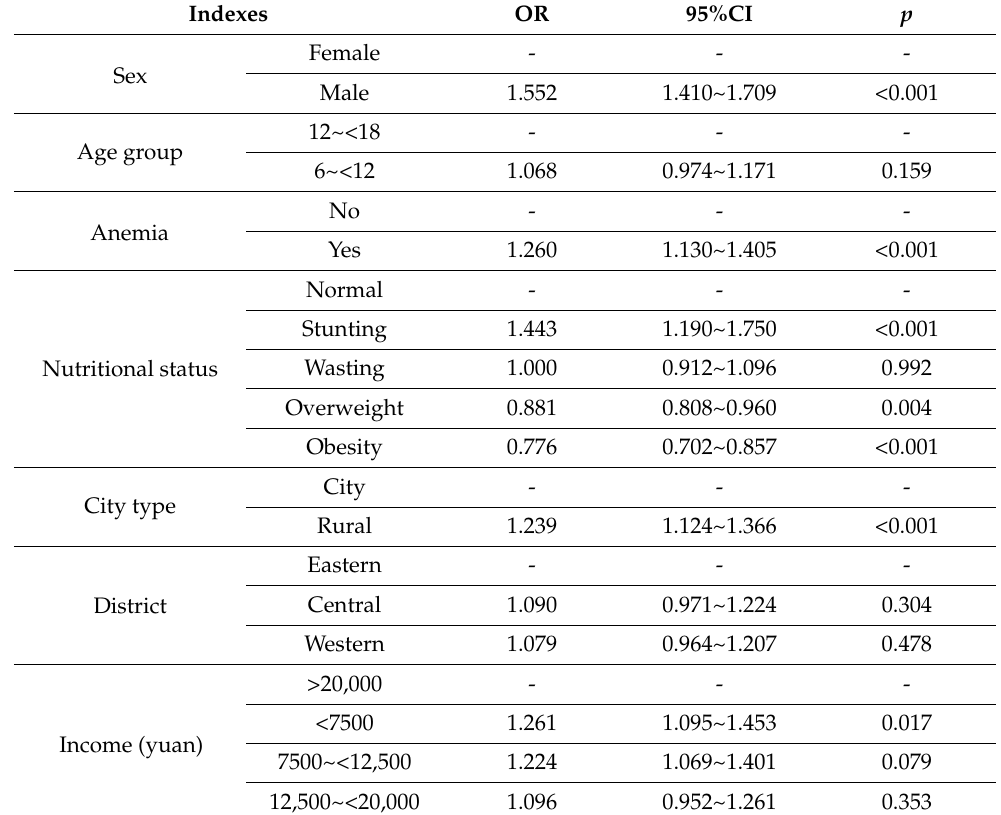
Table 3. Multivariate logistic regression model for risk factors associated with Zn deficiency.